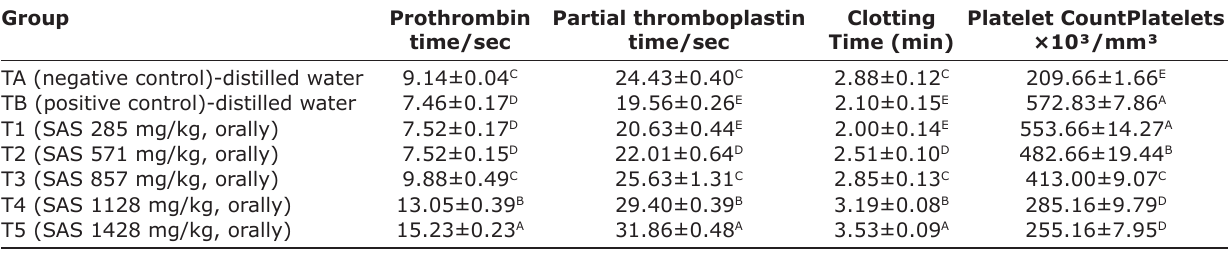
Table-1: The anticoagulant parameters of different groups of mice (controls and hyperlipidemic) treated with sweet almond suspension (SAS) in different doses daily for 60 consecutive